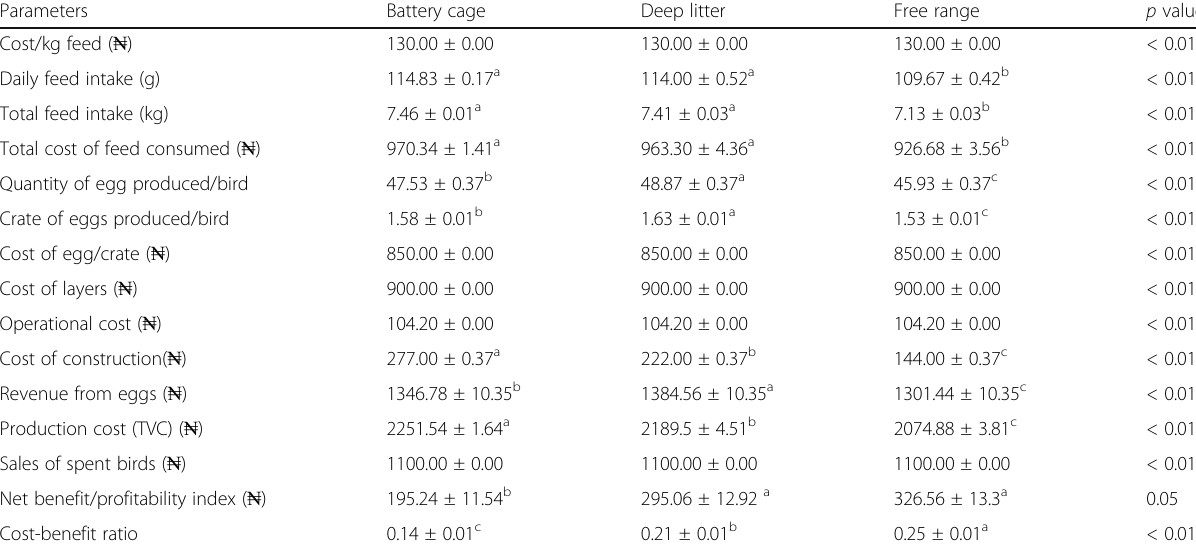
Table 3 Economy of production of Isa Brown layers on different management systems